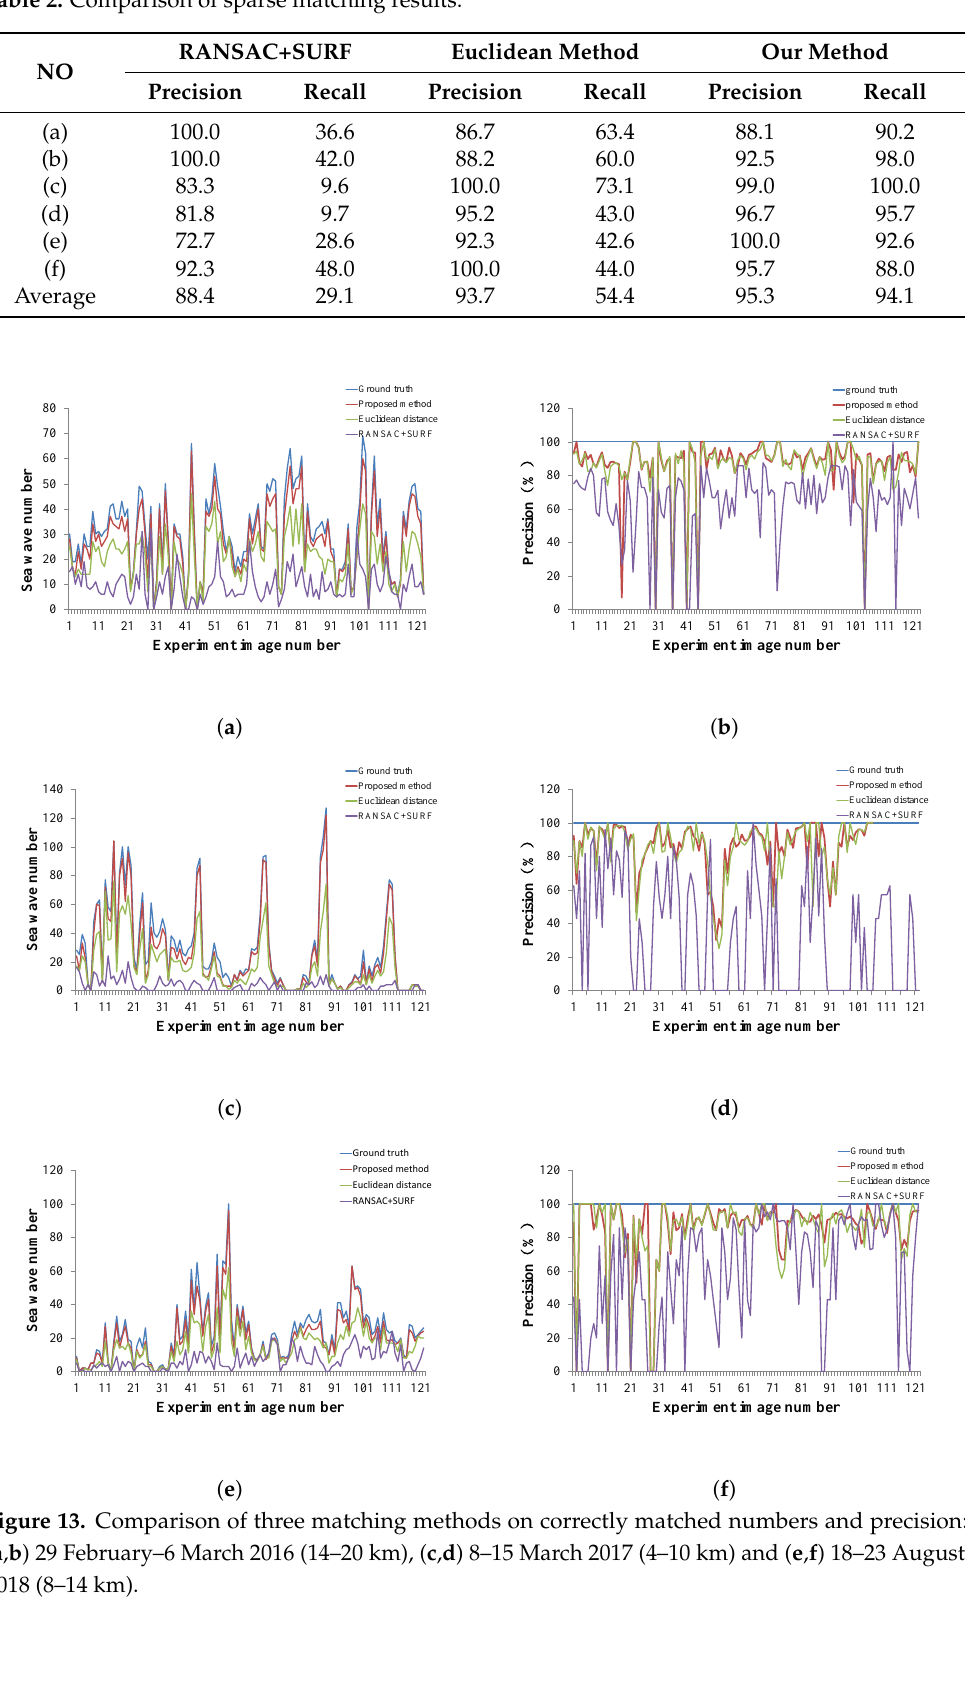
Table 2. Comparison of sparse matching results.